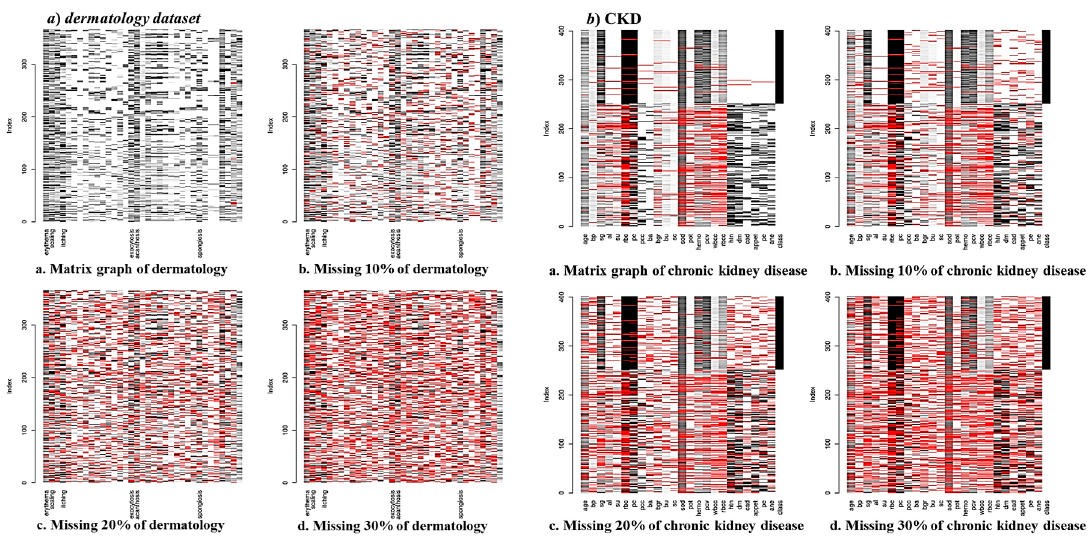
Figure 5. Matrix graph of dataset with varying degrees of missing: ( a ) dermatology dataset; ( b ) chronic kidney disease (CKD).